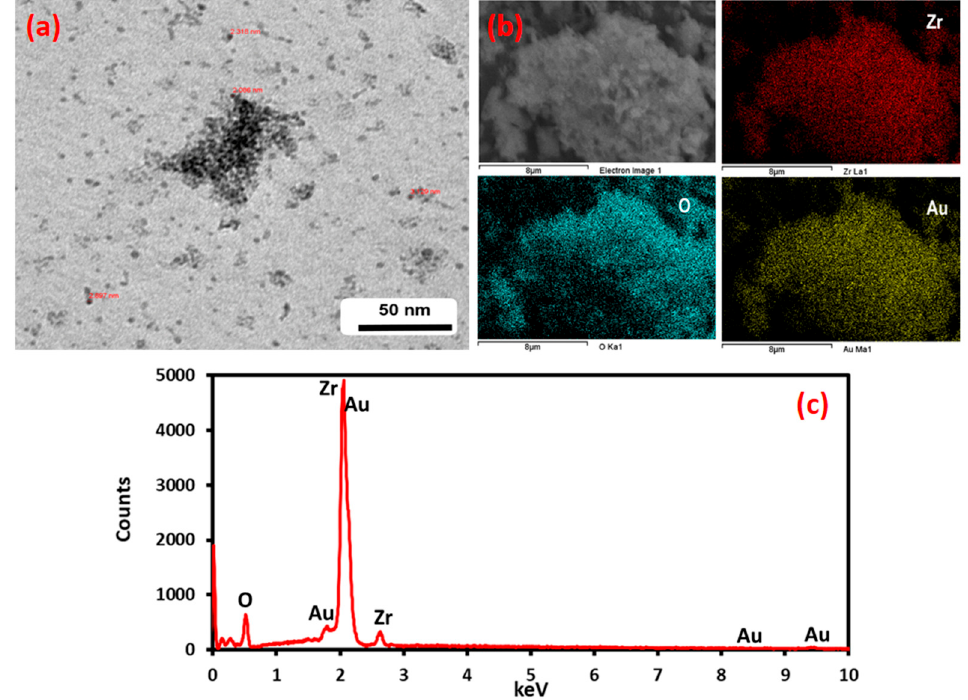
Figure 4. TEM, SEM, and EDX analysis of Au-ZrO 2 . ( a ) The dark contrast in the TEM image indicates the presence of gold nanoparticles ( b ) the color mapping of the sample under SEM analysis clearly indicates the presence of Zr and gold in the sample. ( c ) EDX also points towards the presence of Au and Zr in The Au-ZrO 2 Sample.